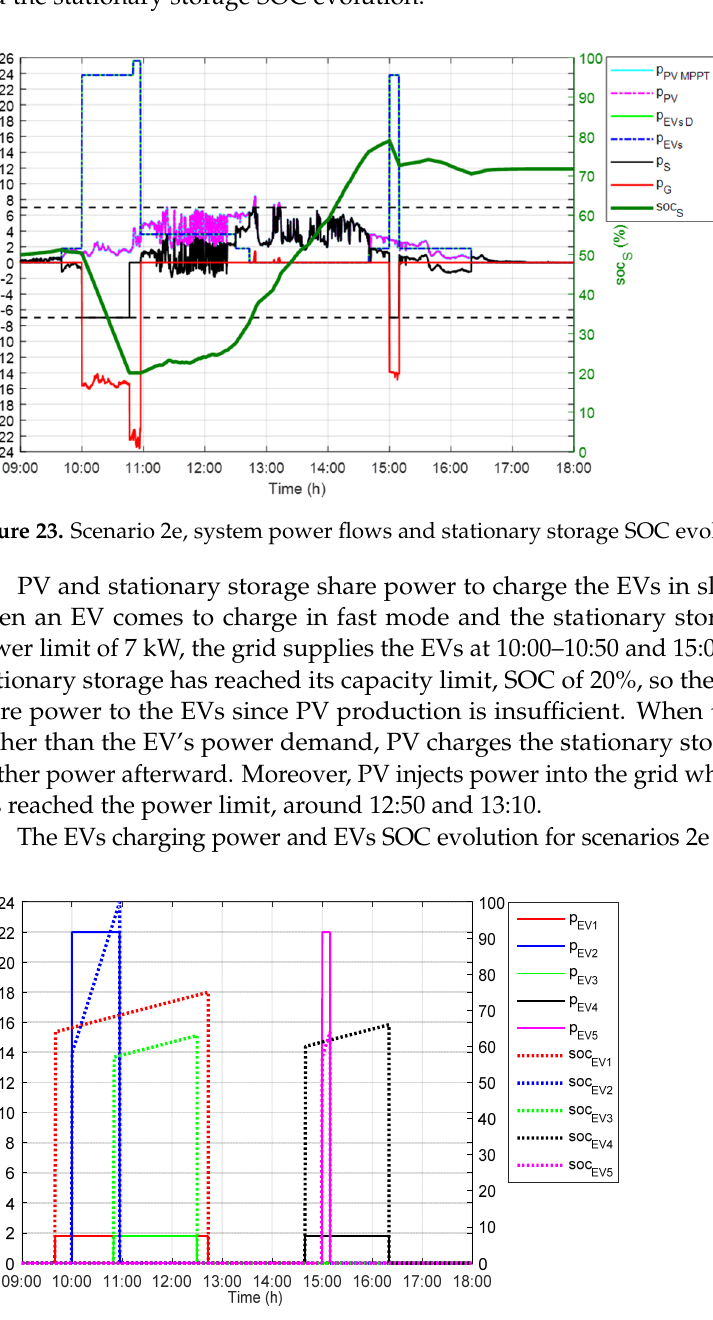
( b ) Figure 22. ( a ) Energy system distribution; ( b ) EVs energy distribution for Scenarios 2c and 2d. In conclusion, scenario 2d shows that EV2 and EV5 consume more PV energy than in scenario 2c and the public grid dependency has been reduced. This shows that the var- iable charging power based on time duration availability can improve the PV benefits and the EVs can depend more on PV and less on the public grid. The stationary storage could be emptied quickly, if its power is not limited, since for EVs charging in fast mode their charging power could reach up to 22 kW. Thus, in scenario 2c, EV2 and EV5 charge with a greater percentage of public grid energy. However, since the stationary storage is charged by PV sources only, as mentioned earlier, this could prove the superiority of sce- nario 2d over scenario 2c, as the PV energy and stationary storage energy combined are higher than scenario 2c, as shown in Figure 22d. 5.2.5. Scenario 2e The hypotheses for scenario 2e are shown in Table 7. Table 7. Hypotheses for Scenario 2e.